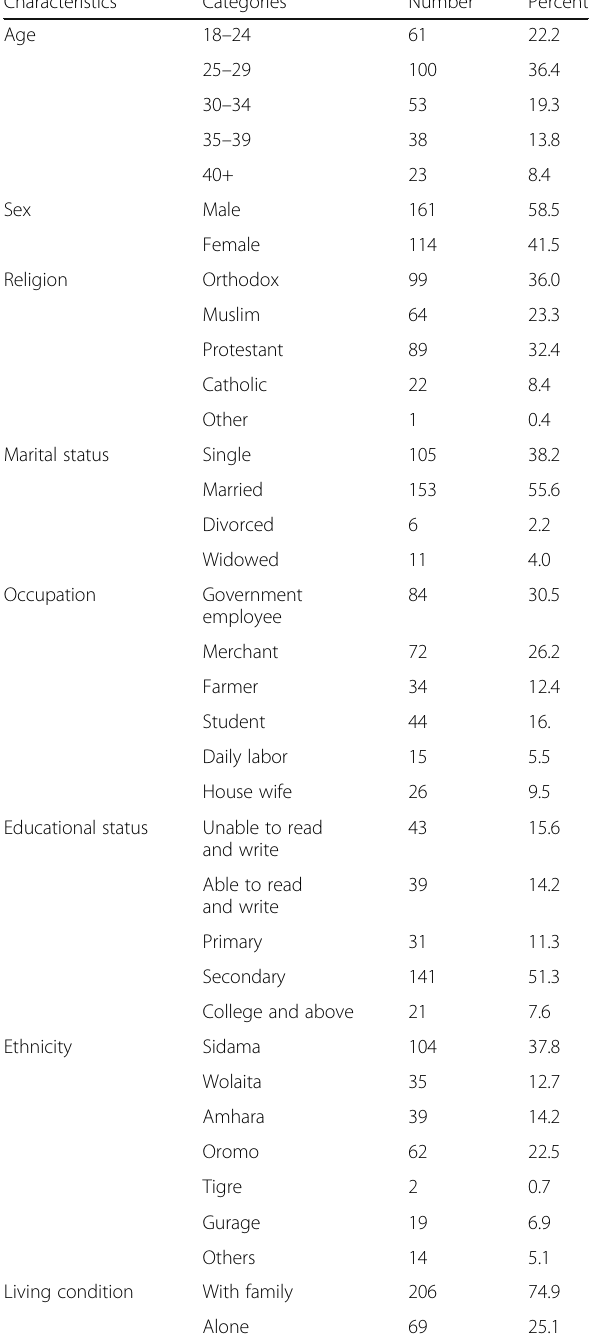
Table 1 Socio-demographic characteristics of study